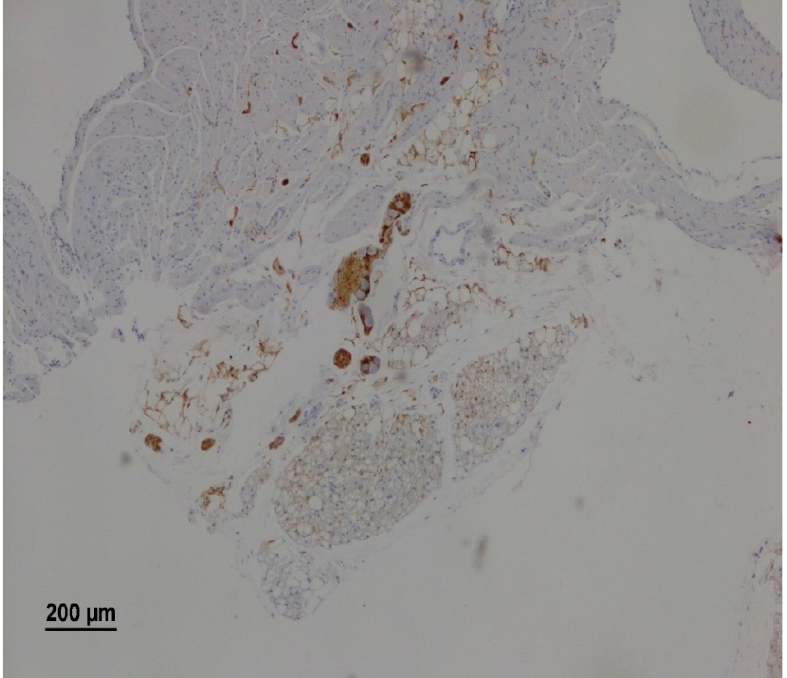
Figure 2. A representative microscopy image showing intramural parasympathetic ganglion. The right atrium of a rat from the RS group on the 25th day after vagotomy. Immunohistochemical staining for S100 b.